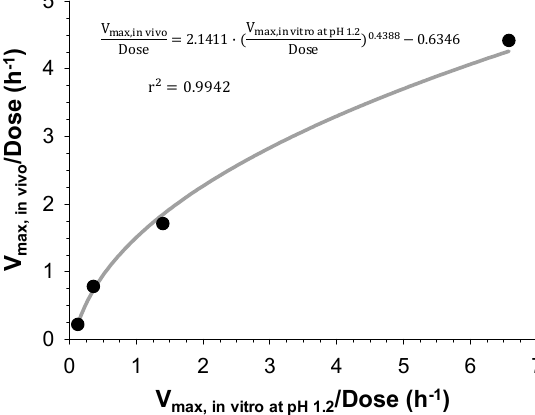
Figure 5. Correlation between the V max estimates for in vitro and in vivo dissolution by a power regression.